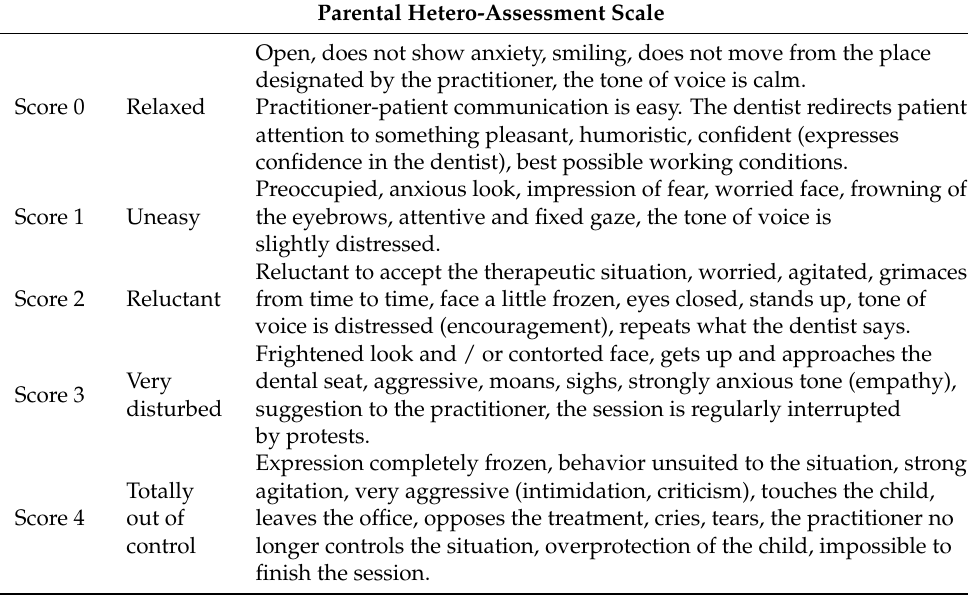
Table 2. Parental hetero-assessment